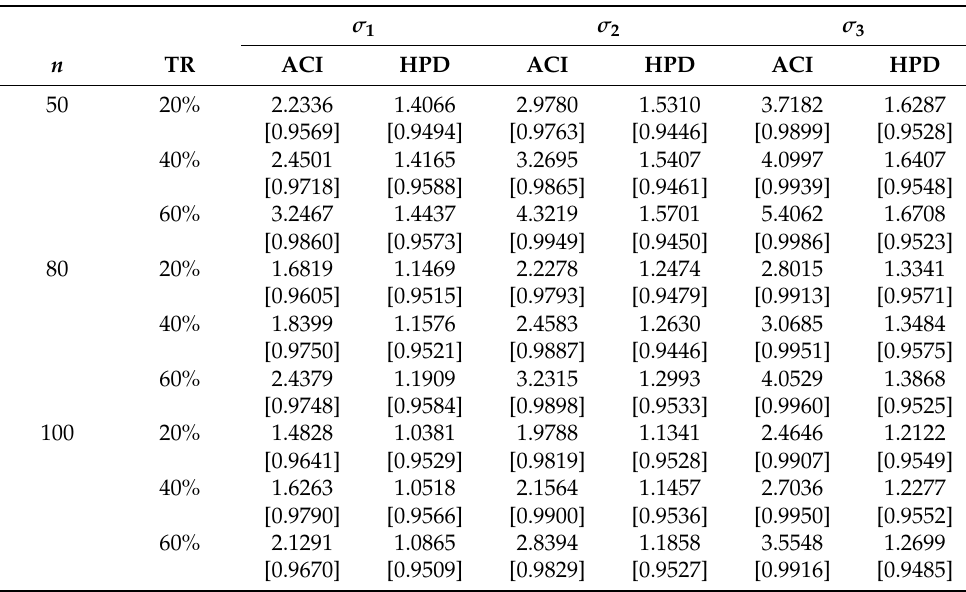
Table 5. ALs and CPs (within bracket) for parameters without order restriction when ( σ 1 , σ 2 , σ 3 ) = ( 1.5,2,2.5 ) .